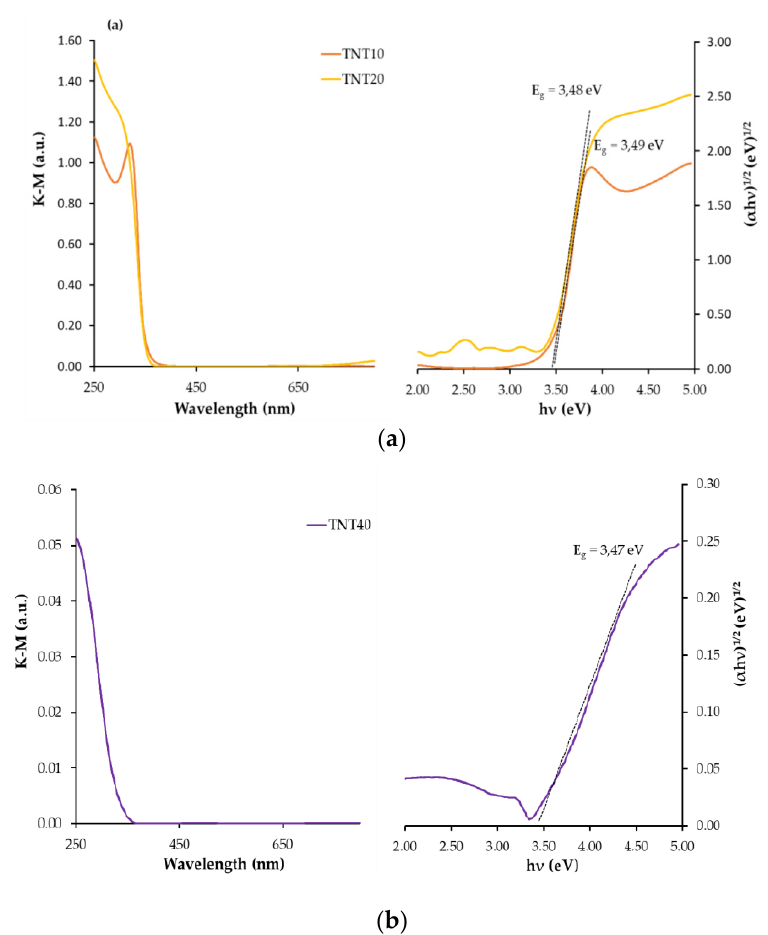
Figure 5. Di ff use reflectance UV-Vis spectra of TNT samples (the left side) and Kubelka–Munk function